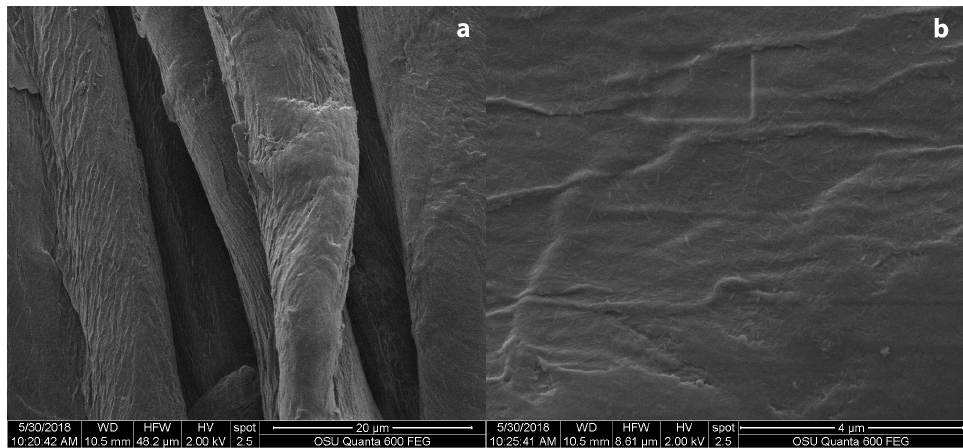
Figure 10. ( a ) Cotton printed with ethanol-based ink, image taken with a FEI Quanta 600; ( b ) Magnification of the printed surface. Image taken with a FEI Helios 650.